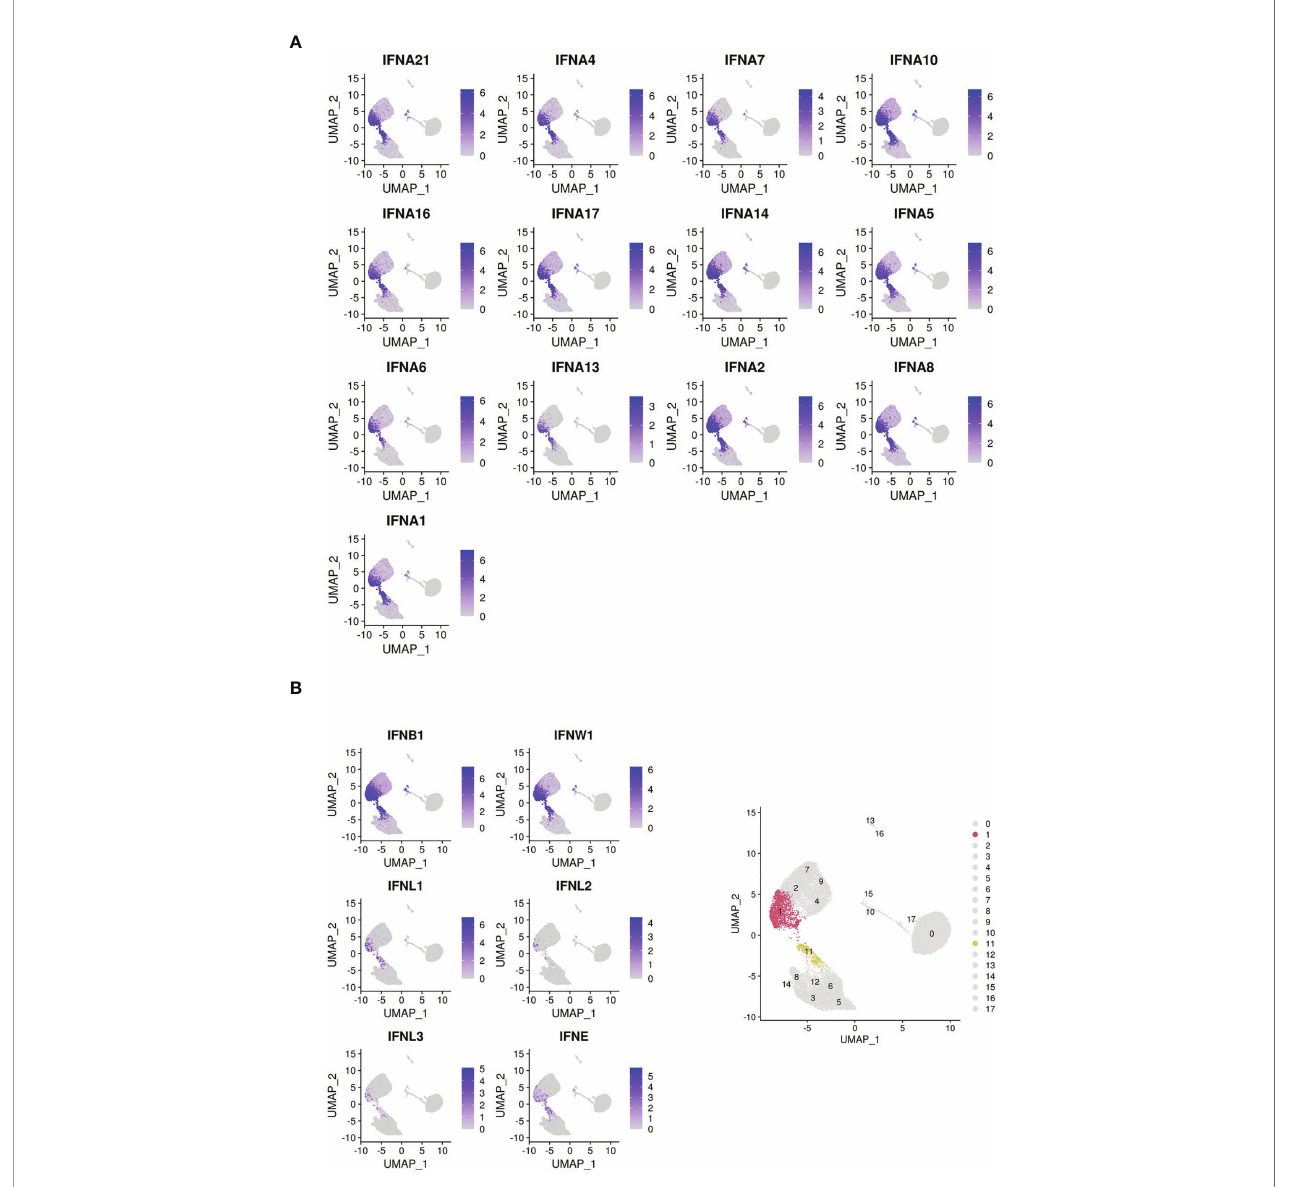
FIGURE 3 | Clusters colored by IFN-I gene expression. (A) Cells colored by IFN- a subtype gene expression. (B) Cells colored by non-IFN- a type I interferon gene expression. Bottom right panel: highlight of clusters 1 and 11 identi fi ed by